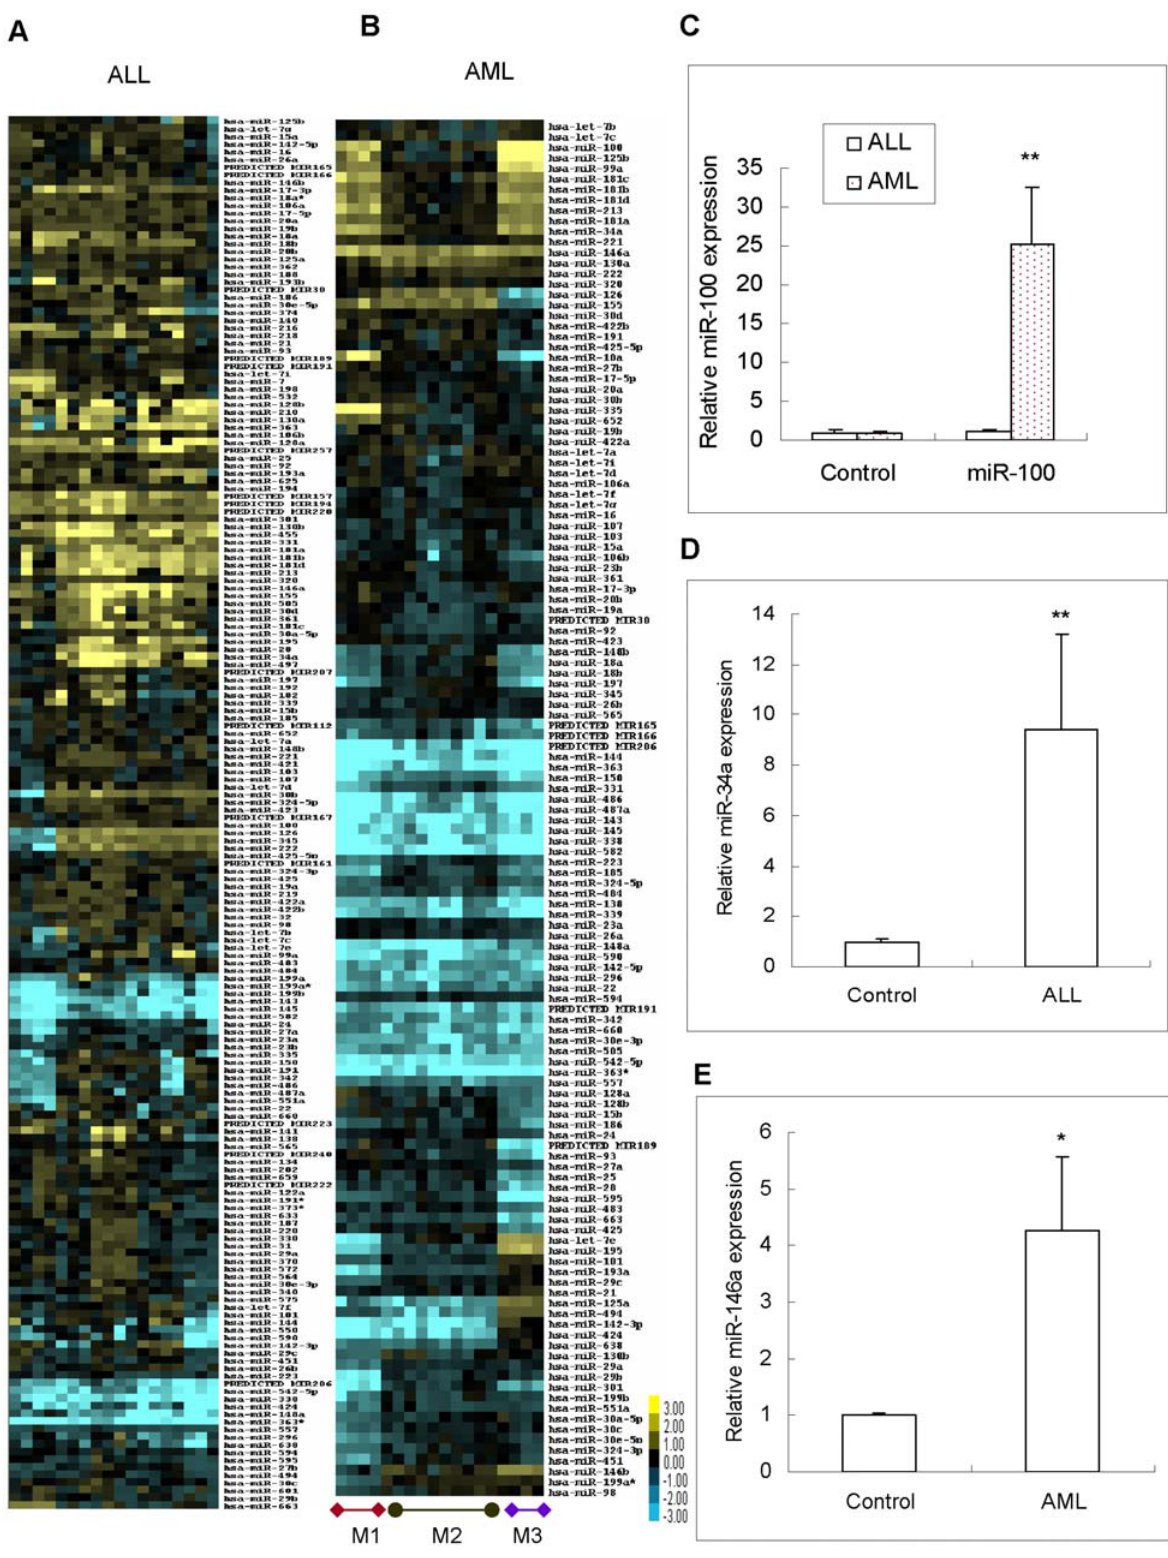
Figure 1. Cluster analysis in pediatric ALL and AML and miRNA expression in pediatric ALL and AML validated with qRT-PCR using the validation cohort. (A) The 182 top–ranked differentially expressed miRNAs in pediatric ALL; (B) The 131 top–ranked differentially expressed miRNAs in the French-American-British (FAB) classification of pediatric AML; (C) MiR-100 expression in pediatric ALL and AML validation cohort (p=0.000); (D) MiR-34a was up-regulated in pediatric ALL validation cohort (p=0.003); (E) MiR-146a was up-regulated in AML validation cohort (p=0.046).